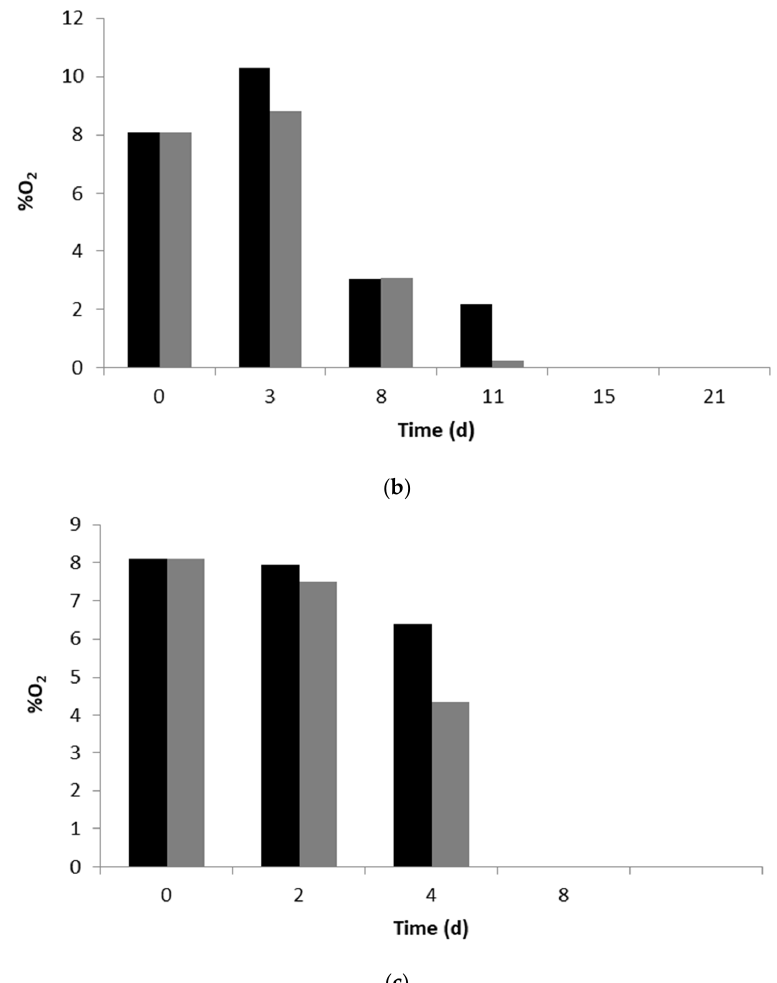
Figure 2. O 2 concentration in the sea bass package headspace during the isothermal storage at ( a ) 0 °C, ( b ) 5 °C, and ( c ) 10 °C ( grey bars ACT-MAP, black bars MAP).